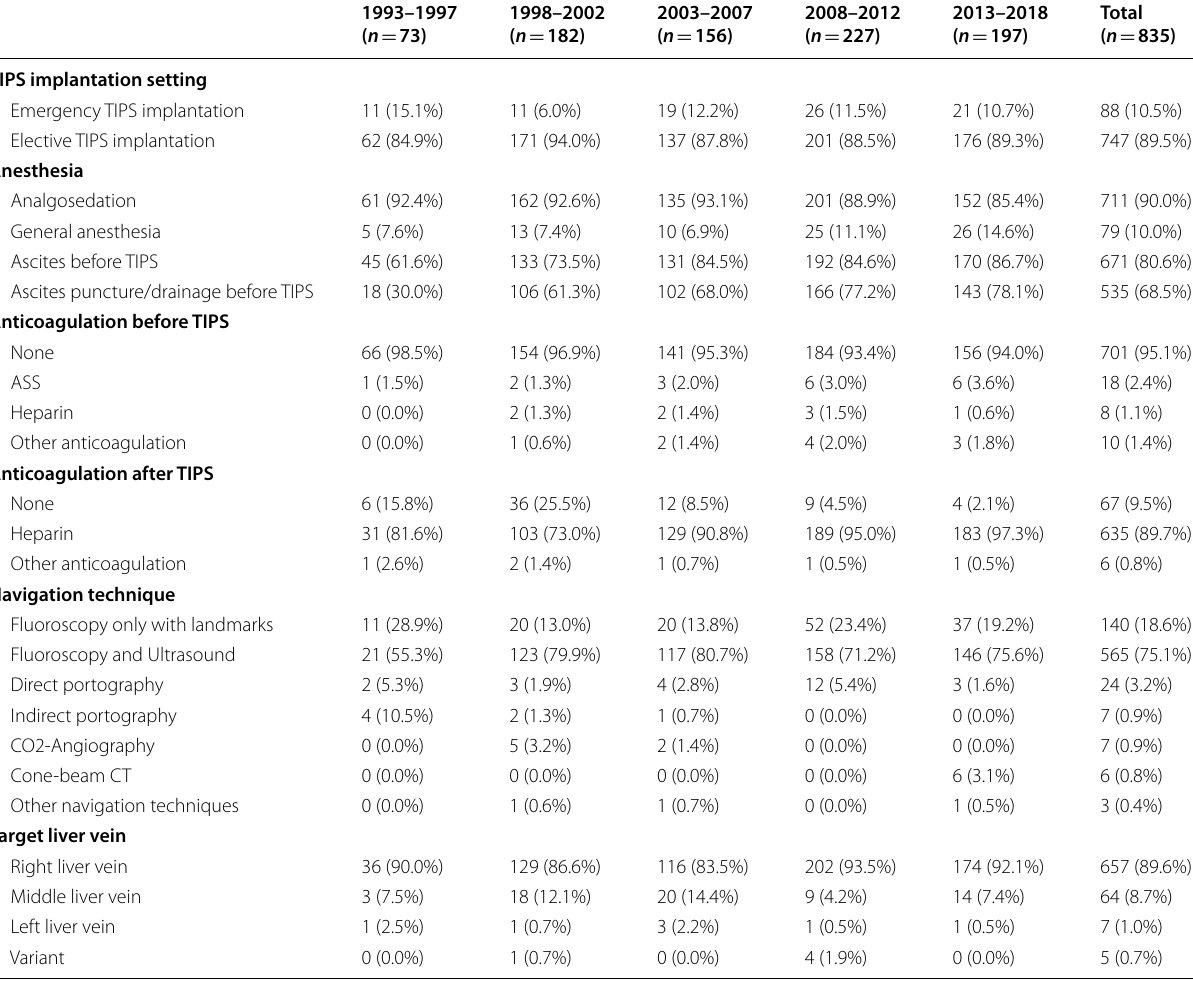
Other anticoagulation before TIPS: clopidogrel, marcumar, combination. Other anticoagulation after TIPS: ASS, clopidogrel, marcumar, combination. Other navigation techniques: cone-beam CT, CT, MRI, combination, CO2 angiography, indirect